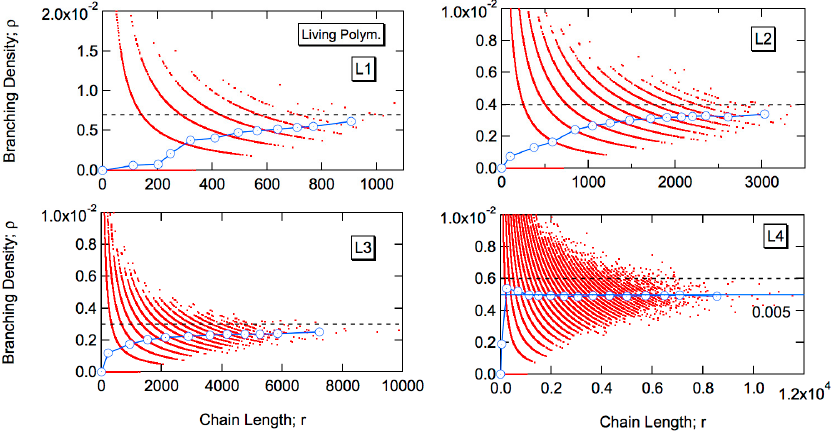
Figure 11. Relationship between the branching density and the chain length in living free-radical emulsion polymerization, for the conditions L1–L4.